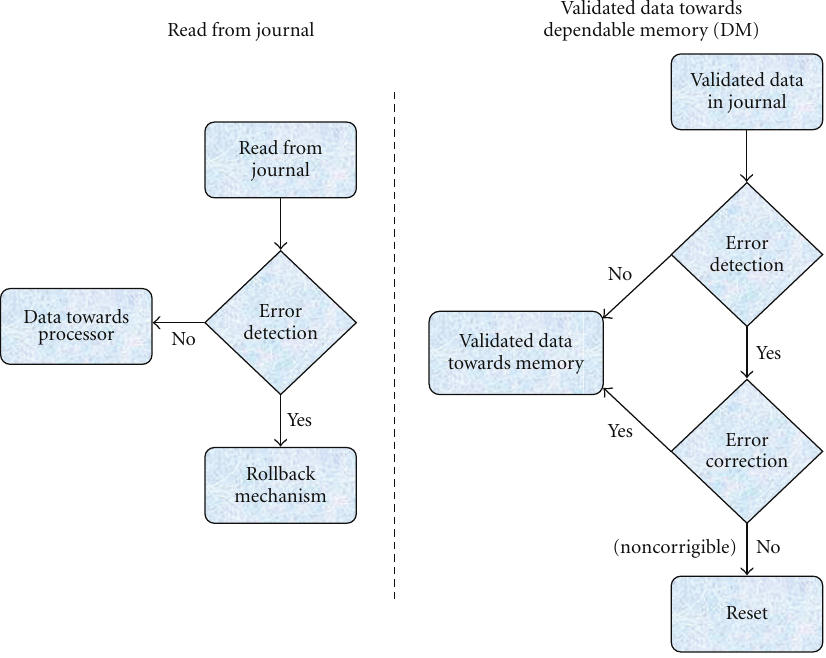
Figure 9: SCHJ operation flow